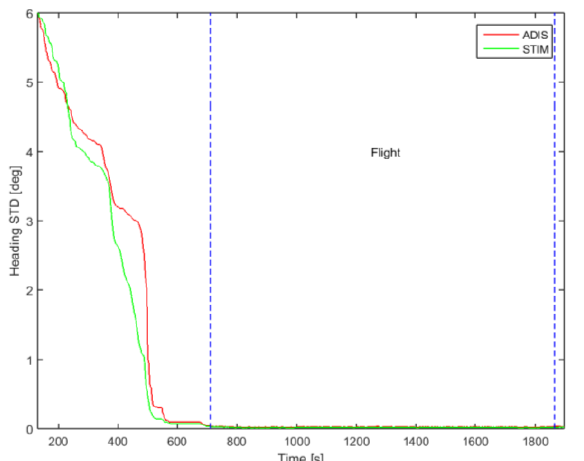
Figure 9. Azimuth convergence time for both IMUs